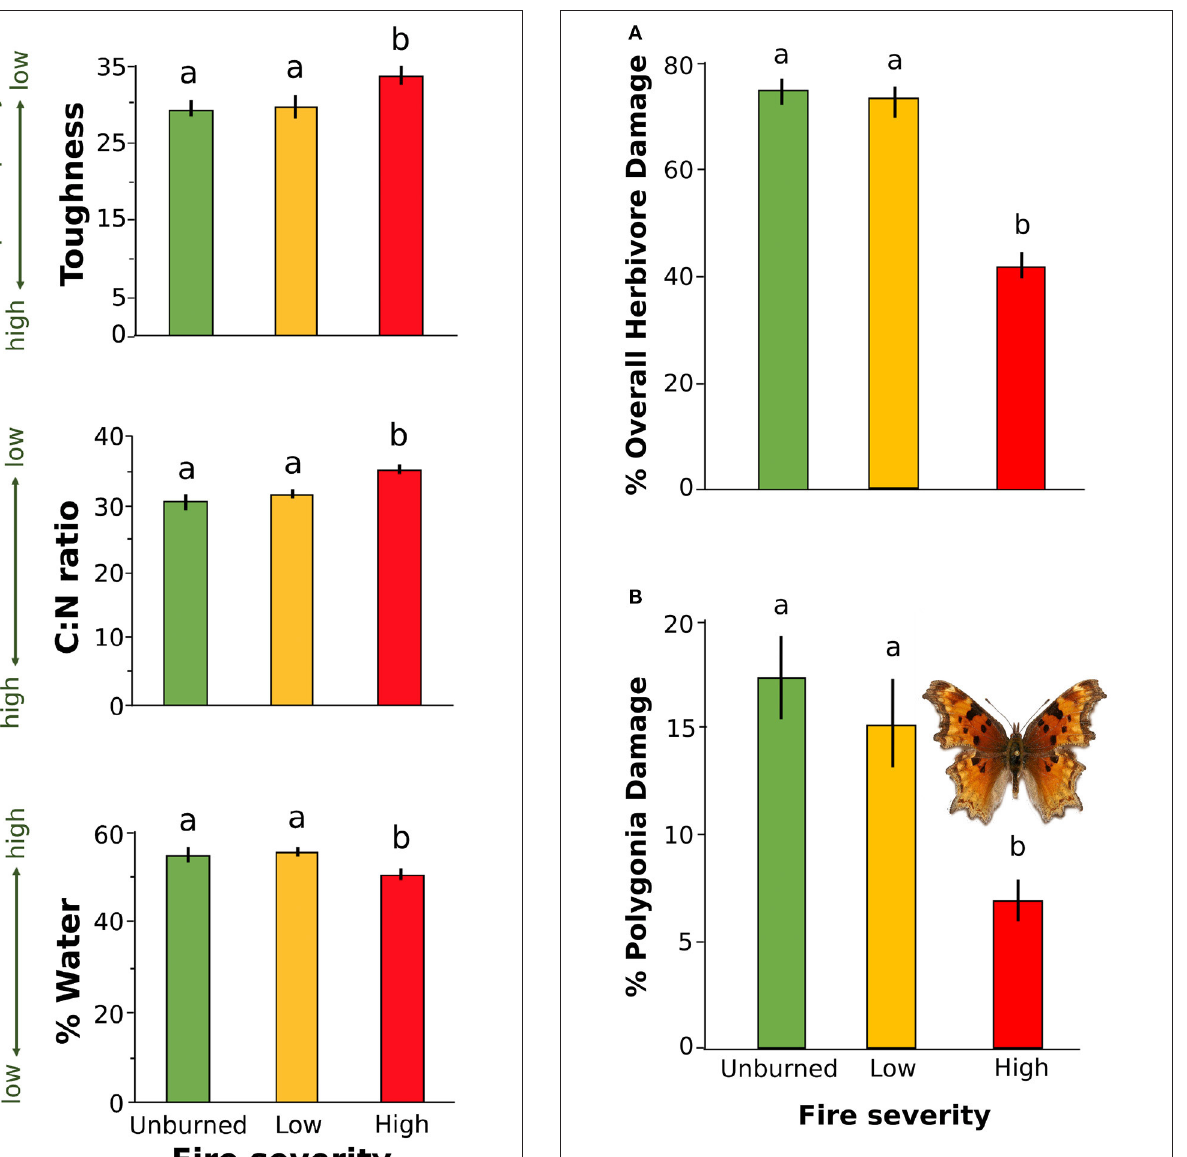
FIGURE 4 | Percent herbivore damage on wax currant plants in unburned, low severity, and high severity fire sites for (A) overall herbivore damage and (B) herbivore damage by Polygonia gracilis zephyrus . Means are given ± SE and letters represent pairwise comparisons within type of herbivore damage ( p <